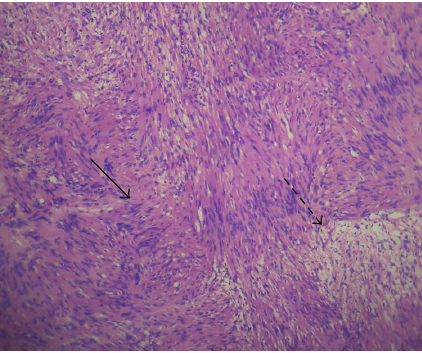
Figure 3: H&E, 100x; Arrow—palisading spindle cells; dotted arrow—collection of foam